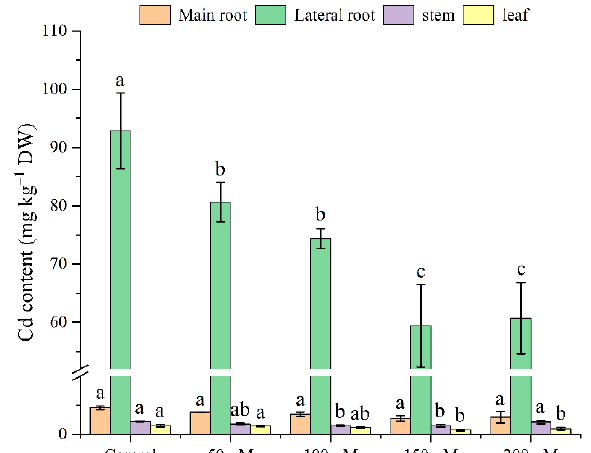
Figure 4. Effects of exogenous melatonin application on the Cd contents of Cd-stressed tea seedlings. The data represent means ± standard deviations for three replicates. Different letters indicate groups that are significantly different at p < 0.05.